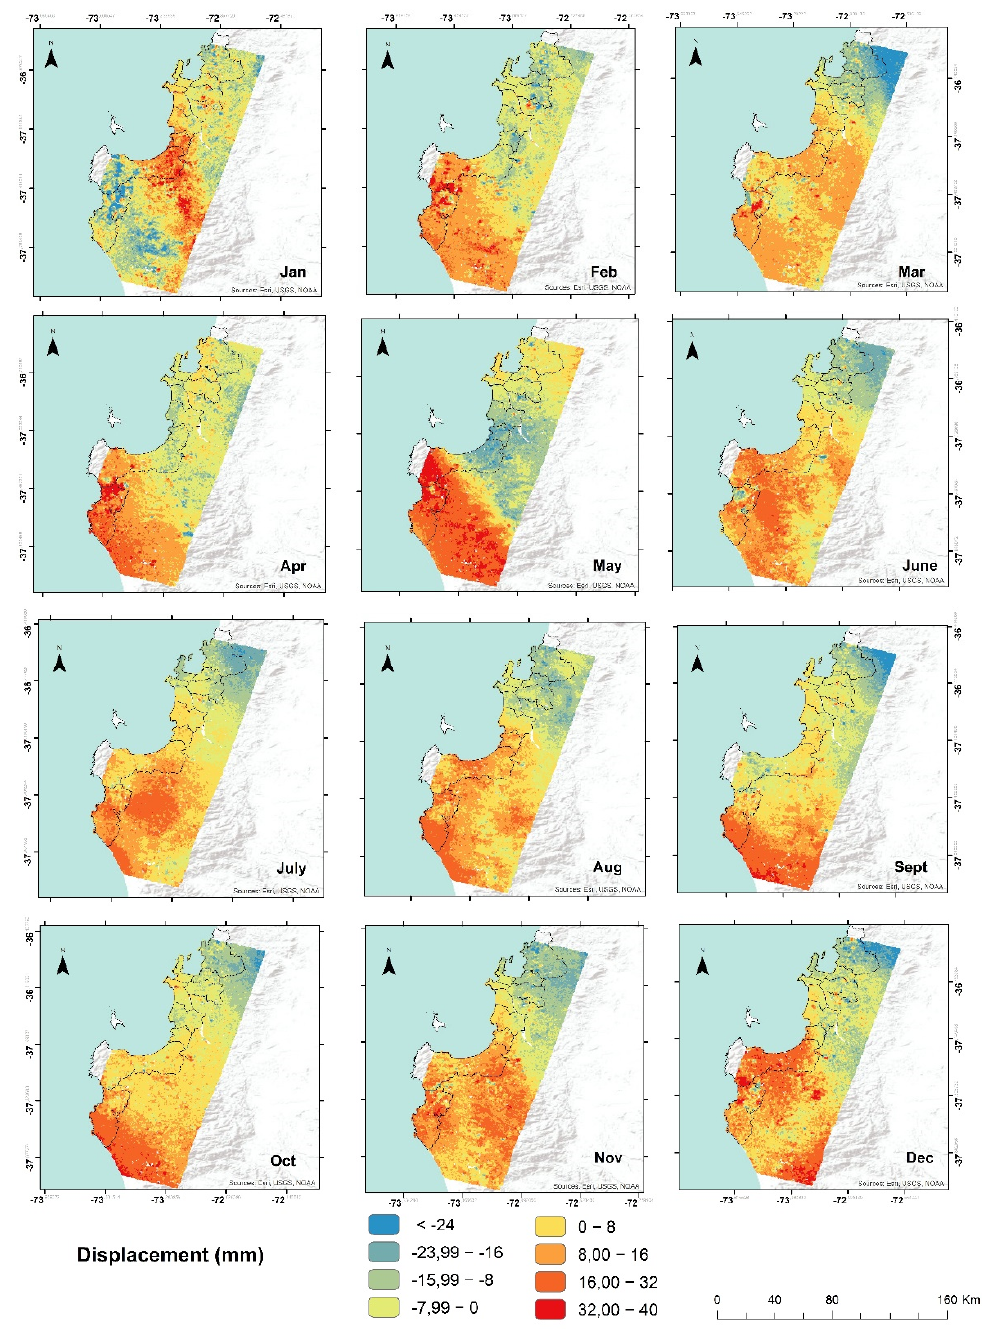
Figure 6. Monthly deformation maps for the year 2017.